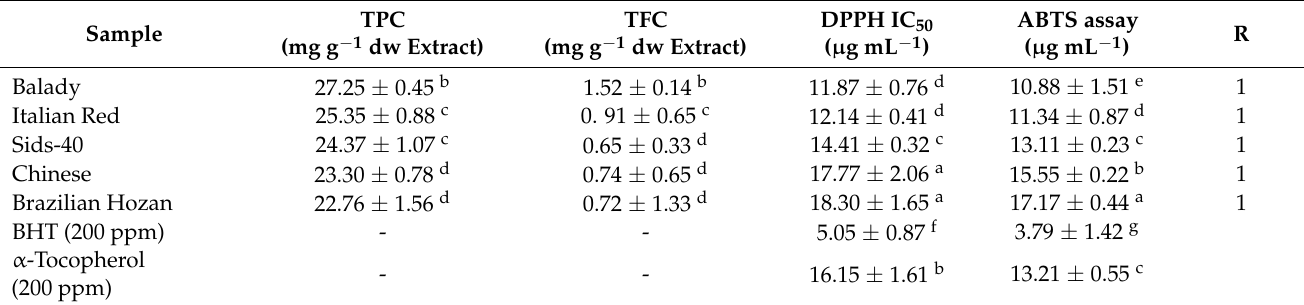
Table 1. Total phenolic content (TPC), Total flavonoid content (TFC), and antioxidant activities (AA) of garlic extracts from different cultivars compared to BHT and α -tocopherol (mean ± SD, n =